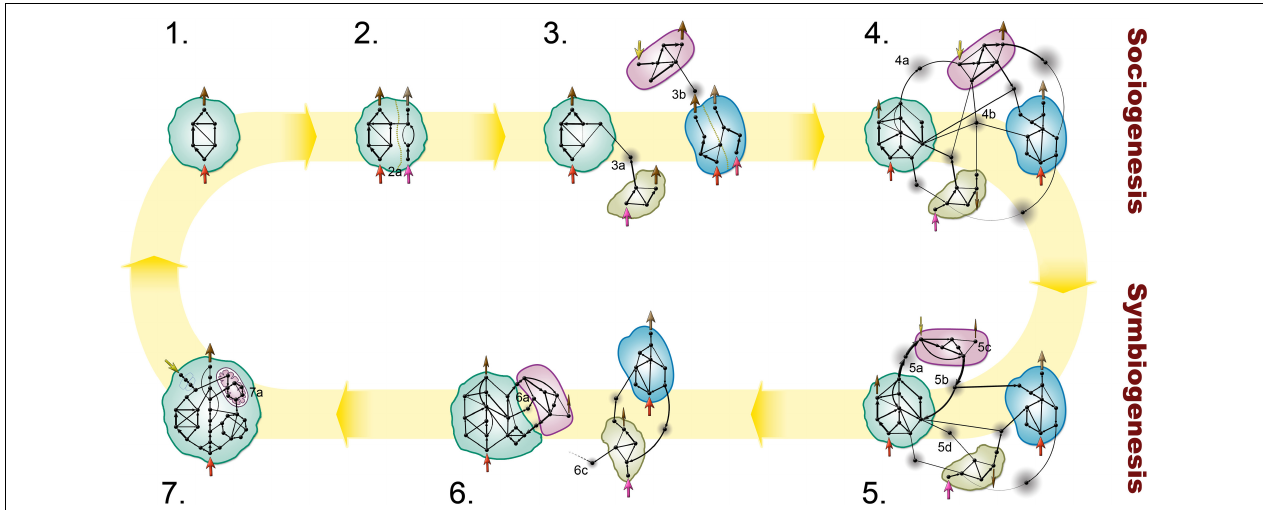
FIGURE 2 | A theoretical scenario of the evolution of a microbial facilitation network. (1) Microbes (colored blobs) reproduce independently with self-sustaining metabolisms. Metabolism is represented as a network of metabolites (black dots) and reactions (black arrows) indicating the main directionality and weight of the metabolic flow. Inflow and outflow are depicted as arrows pointing in and out of cells, respectively. The yellow background cycle represents a possible evolutionary route; note that the route can branch or reverse at any point. (2) Phenotypic plasticity allows the organisms to adapt to environmental changes. E.g., mutually exclusive metabolic pathways within an individual (step 2, separated by a dotted line) can utilize different resources efficiently, but not both (differently colored inflows at 2a). (3) In a community, different species may specialize on a resource while relying on community members for the utilization of other resources. According to the Black Queen hypothesis, metabolic division of labor can evolve when the shared metabolism is partitioned and distributed among species that complement each other via diffusible, leaky products (gray nodes between cells indicate diffusion of released products; 3a, 3b). (4) Selection can further increase cross-dependency, resulting in a multi-context division of labor with several types of mutual dependencies (i.e., nutritional, protection). Public goods can be exclusively used by two species (4a), or by anyone in the community (4b). (5) Symbiosis may emerge if two organisms separate from the community by relying less on public goods (5d), by downregulating pathways relying on third party resources (5c), and strengthening reciprocal cooperation by increased production rates of compounds that benefit the partner (5a, 5b). Such compounds can still serve as public goods (5b) giving rise to free-riders. (6) Partners can secure a more efficient exchange to exclude free-riders by privatizing resources (6a). Symbiotic pairs can gradually decouple from the community (6c) which may still provide a stable environment for them. (7) The transition in individuality becomes complete when no partner can reproduce alone anymore (e.g., endosymbiont gets fully integrated; (7a). The new unit of evolution acts as a single individual, and the cycle may continue at step 1 (ignoring its higher internal complexity). Ecological and evolutionary timescales are not